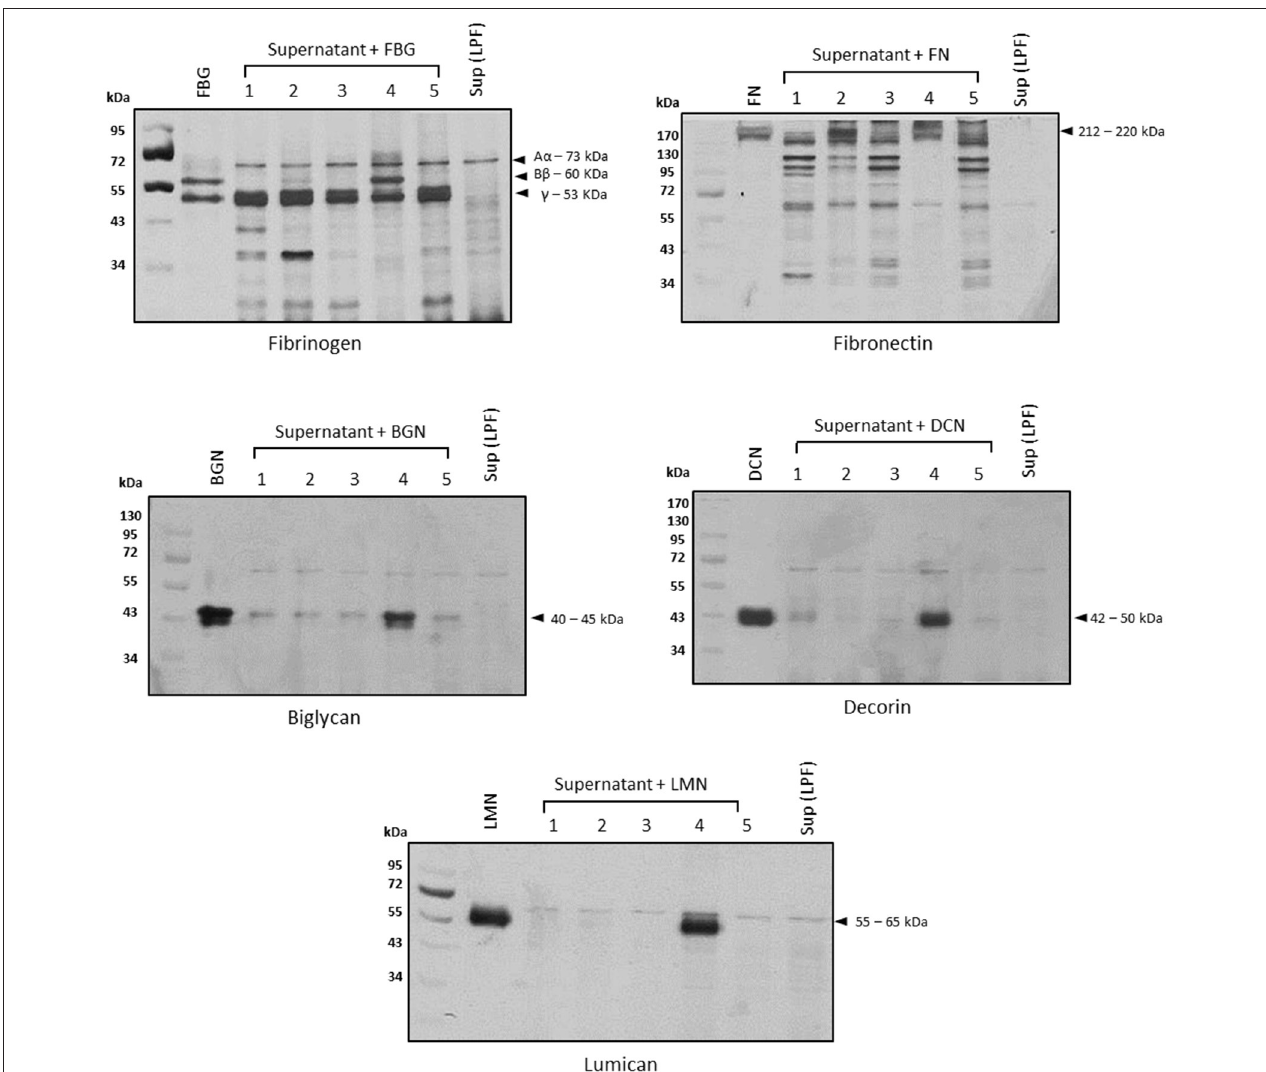
FIGURE 3 | Proteolytic activities are inhibited by 1,10-phenanthroline. Before the addition of each substrate, the supernatant of pathogenic Leptospira interrogans serovar Kennewicki strain Fromm (0.5 µ g of total secreted proteins) was incubated with inhibitors of serine proteases (5 mmol/L PMSF; lane 2), cysteine proteases (28 µ mol/L E-64; lane 3), metalloproteases (5 mmol/L 1,10-phenanthroline; lane 4), or aspartyl proteases (5 µ mol/L pepstatin; lane 5) for 30min at room temperature. Substrates were added and incubations proceeded for 18h. Cleavage products were analyzed by SDS- polyacrylamide gel under reducing conditions. Gels